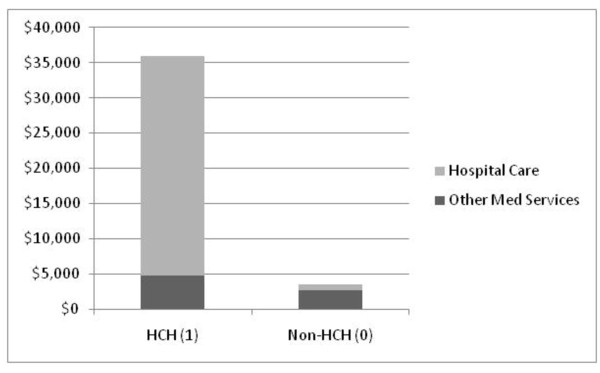
Comparison of High Cost Hospital (HCH) group to non-High Cost Hospital (non-HCH) group. Stacked histogram comparing average annual total per patient healthcare payments in the HCH and non-HCH groups. Black equals payments for physicians and other medical services; gray equals payments for hospital services only.